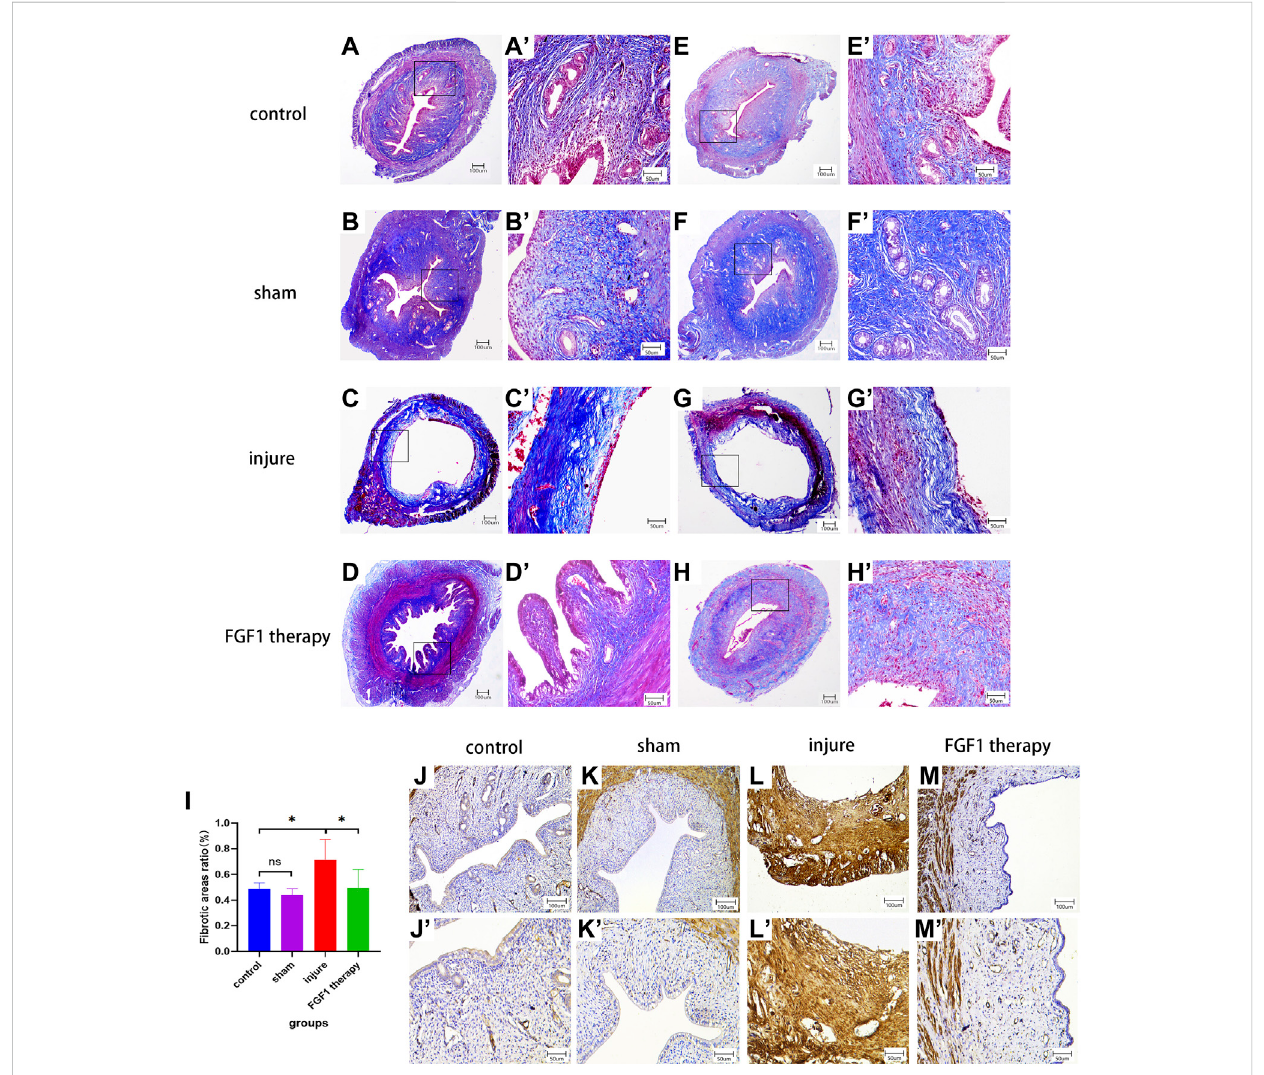
FIGURE 2 FGF1 reduces the degree of thin endometrial fi brosis. Masson staining of the endometrium. (A – H) 40X, (A ’– H ’ ) 200X. Fibrotic area to endothelial area ratio statistics by each group. n= 6, ns > 0.05, * p < 0.05 (I) . IHC results shows variations in α SMA expressionin each experimental team. (J – M) 100X, (J ’– M ’ )